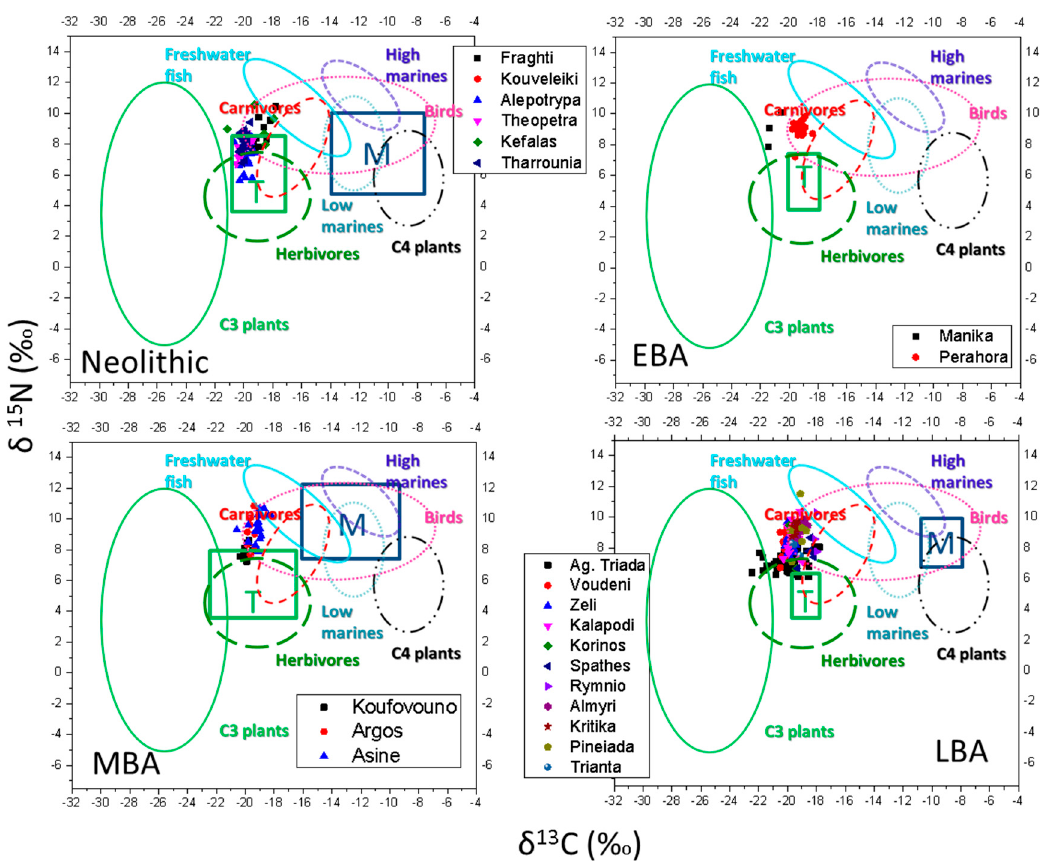
Figure 4. Isotopic values of human bones collagen from the referred archaeological sites versus the fauna baselines of the periods, both terrestrial and marine (rectangles T and M respectively). The circles of the food database of Figure 3b are also presented.